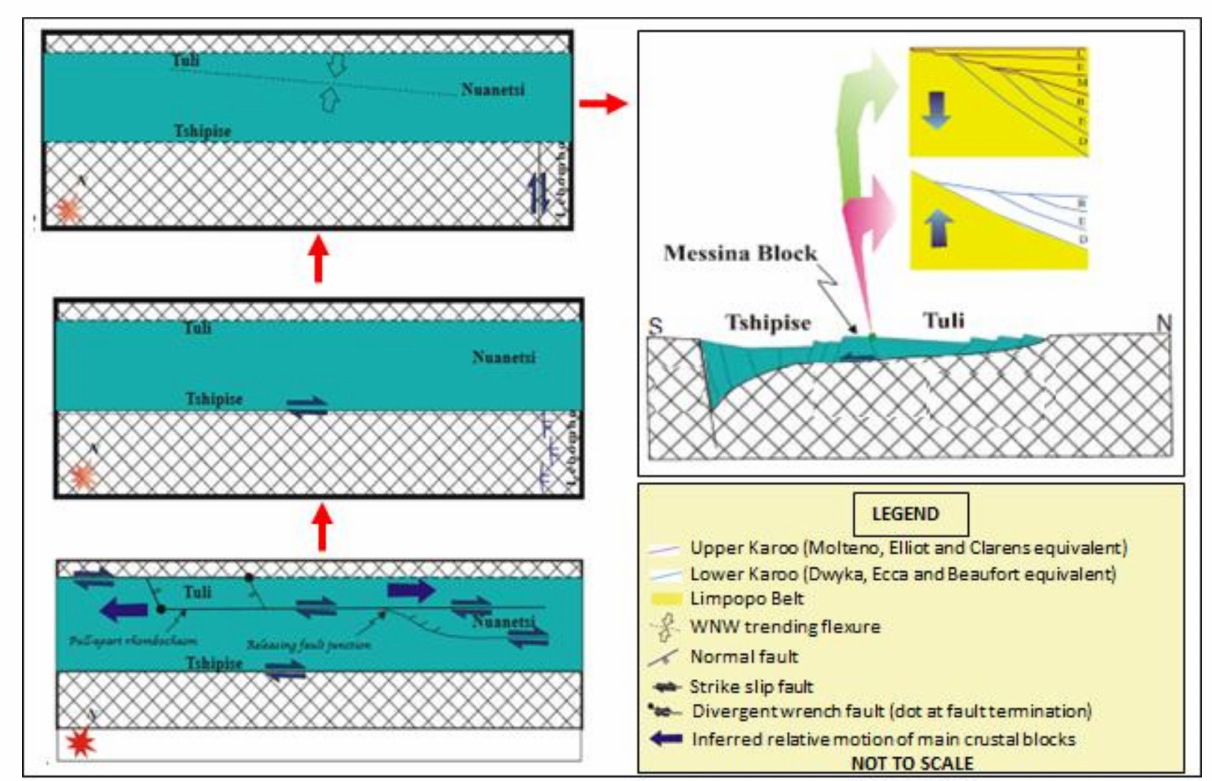
Figure 2. Tectonic evolution model of Limpopo Karoo Basins and the Lebombo Monocline (after [1]). Note: red stars in Figure 2 show the cardinal direction (north is shown as